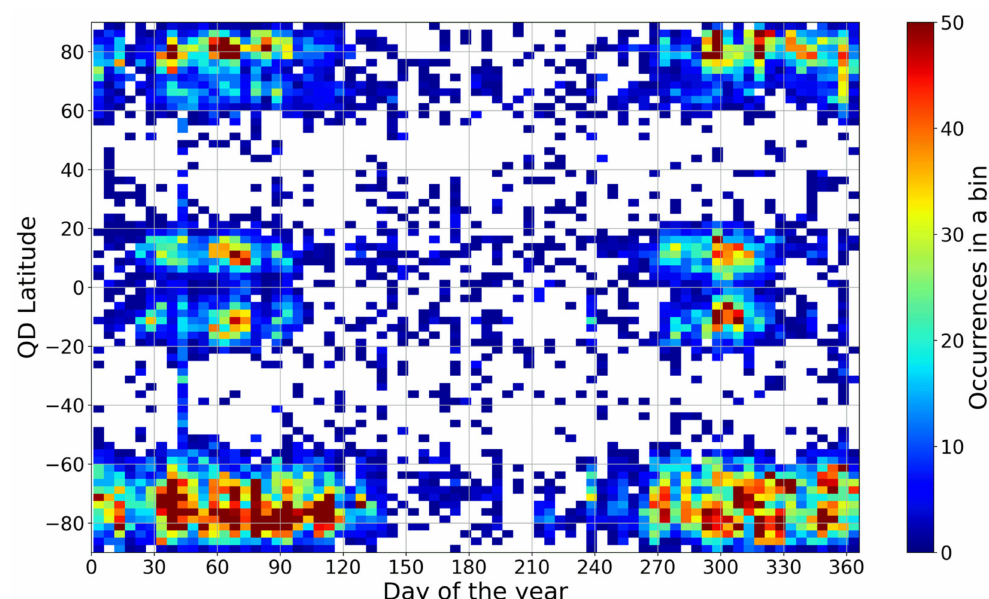
Figure 4. Distribution of the GPS LoL occurrence affecting Swarm A, B, and C, from December 2013 to December 2020, as a function of the QD latitude and the day of the